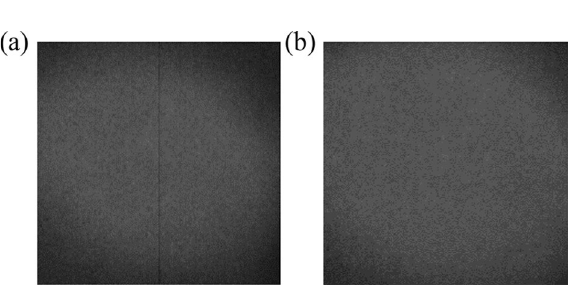
Figure 6. ( a ) Interferogram from BF1 of the 1D interferometer, ( b ) Interferogram from BF1 of the 2D